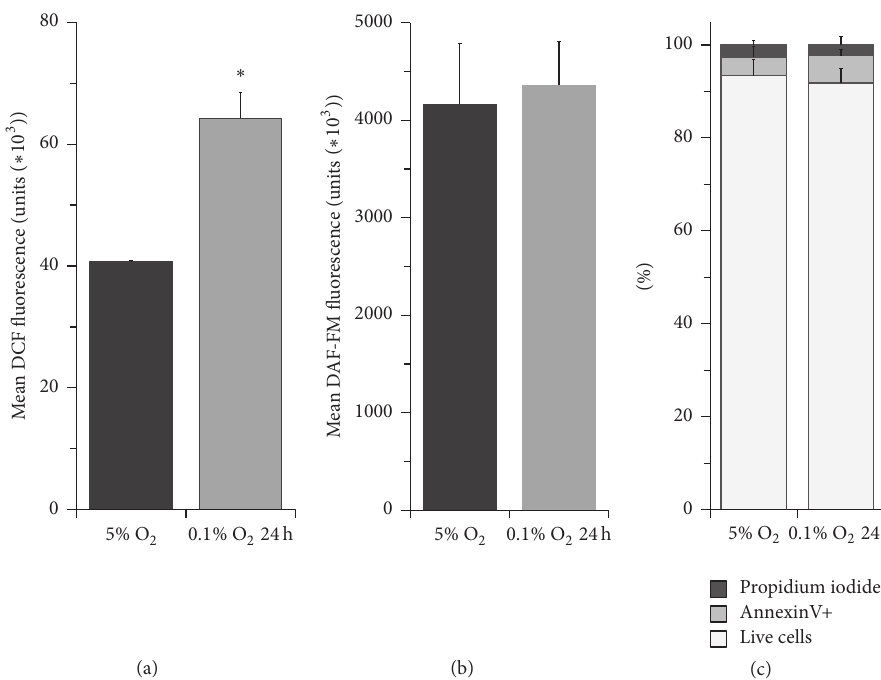
Figure 2: Hypoxic stress induces intracellular ROS but does not affect adipose tissue-derived mesenchymal stromal cell viability. (a) Intracellular ROS were detected with CM-H 2 DCFDA (10 𝜇 M for 20 min) and analysed by flow cytometry. (b) Intracellular NO levels were evaluated by flow cytometry using DAF-FM diacetate (2 𝜇 M for 30 min, followed by a 30 min incubation in fresh medium for complete deesterification). (c) Cell viability was determined by analysing AnnexinV and propidium iodide binding by flow cytometry. Data represent the mean + standard deviation ( 𝑛 = 3 ), ∗ 𝑝 < 0.05